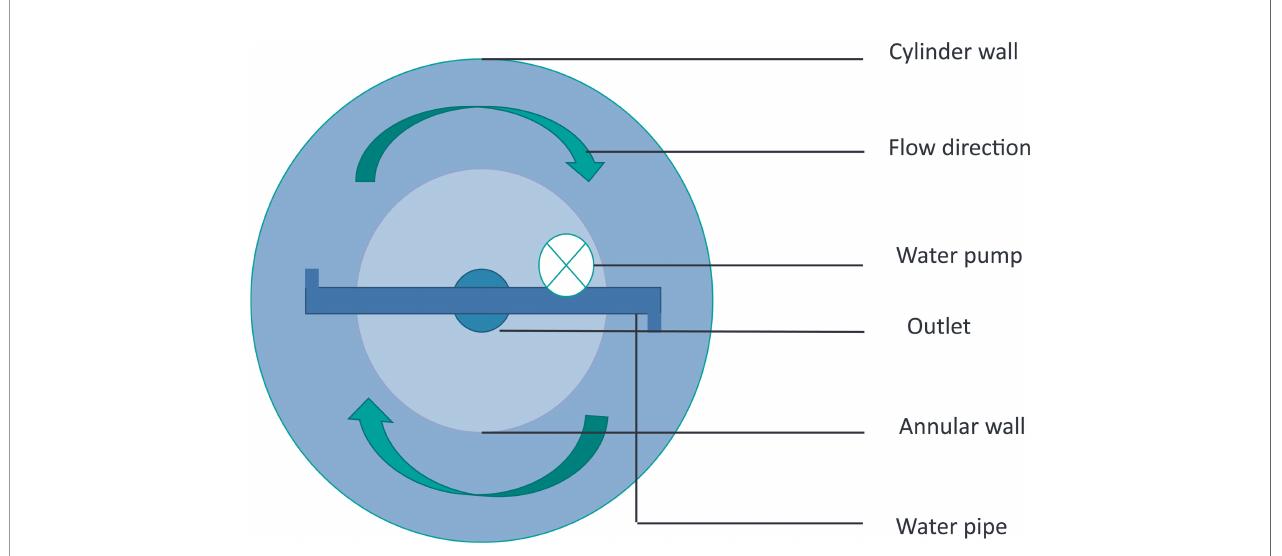
FIGURE 1 | Schematic diagram of the cylindrical glass fi ber tank with water stimulation